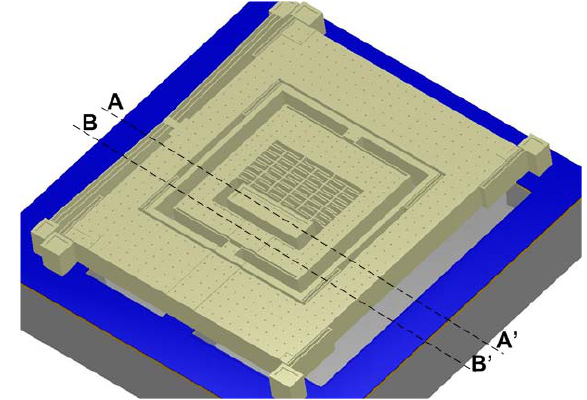
Figure 8. Microgyroscope fabricated through MetalMUMPs process using L-Edit of